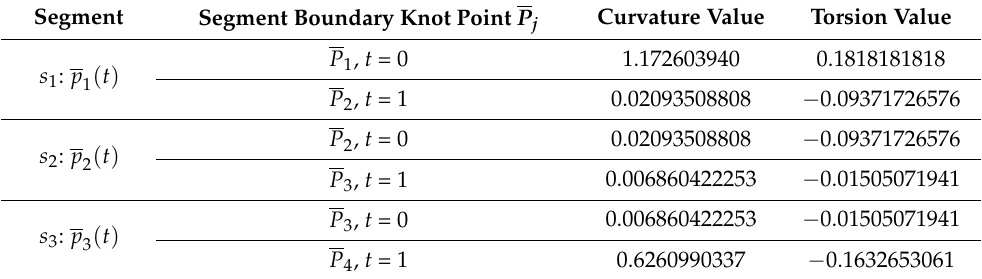
Table 5. Curvature and torsion values at boundary points of the